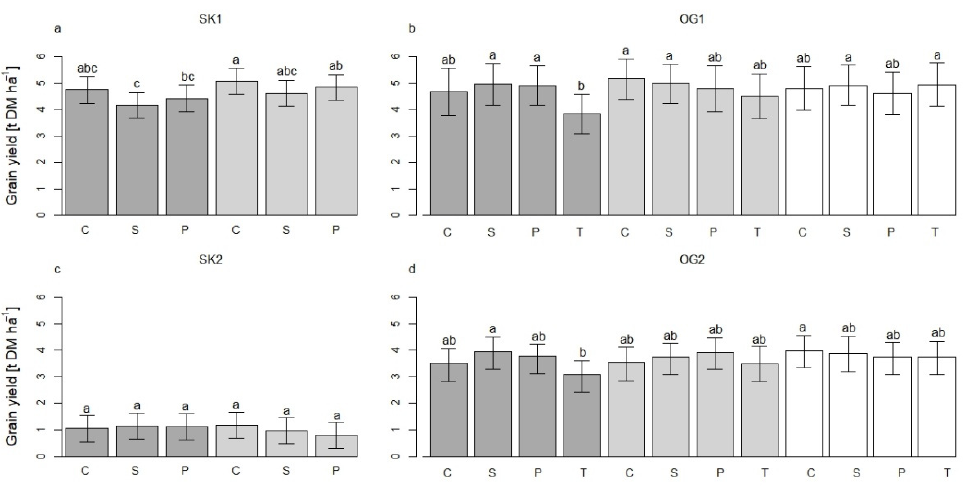
Figure 7. Oat dry matter (DM) grain yield in the four experiments ( a – d ). Abbreviations: SK and OG stands for the two experimental regions, 1 = starting 2017, 2 = starting 2018, C = no service crop, S = frost-sensitive annuals, P = perennials, T = frost-tolerant annuals. Colour coding: dark grey = Early Intra, light grey = Late Inter, white = Late Adjacent. See Materials and Methods and Table 1 for detailed information. Error bars indicate the 95% confidence interval, and the letters indicate significant differences between treatments within each experiment.